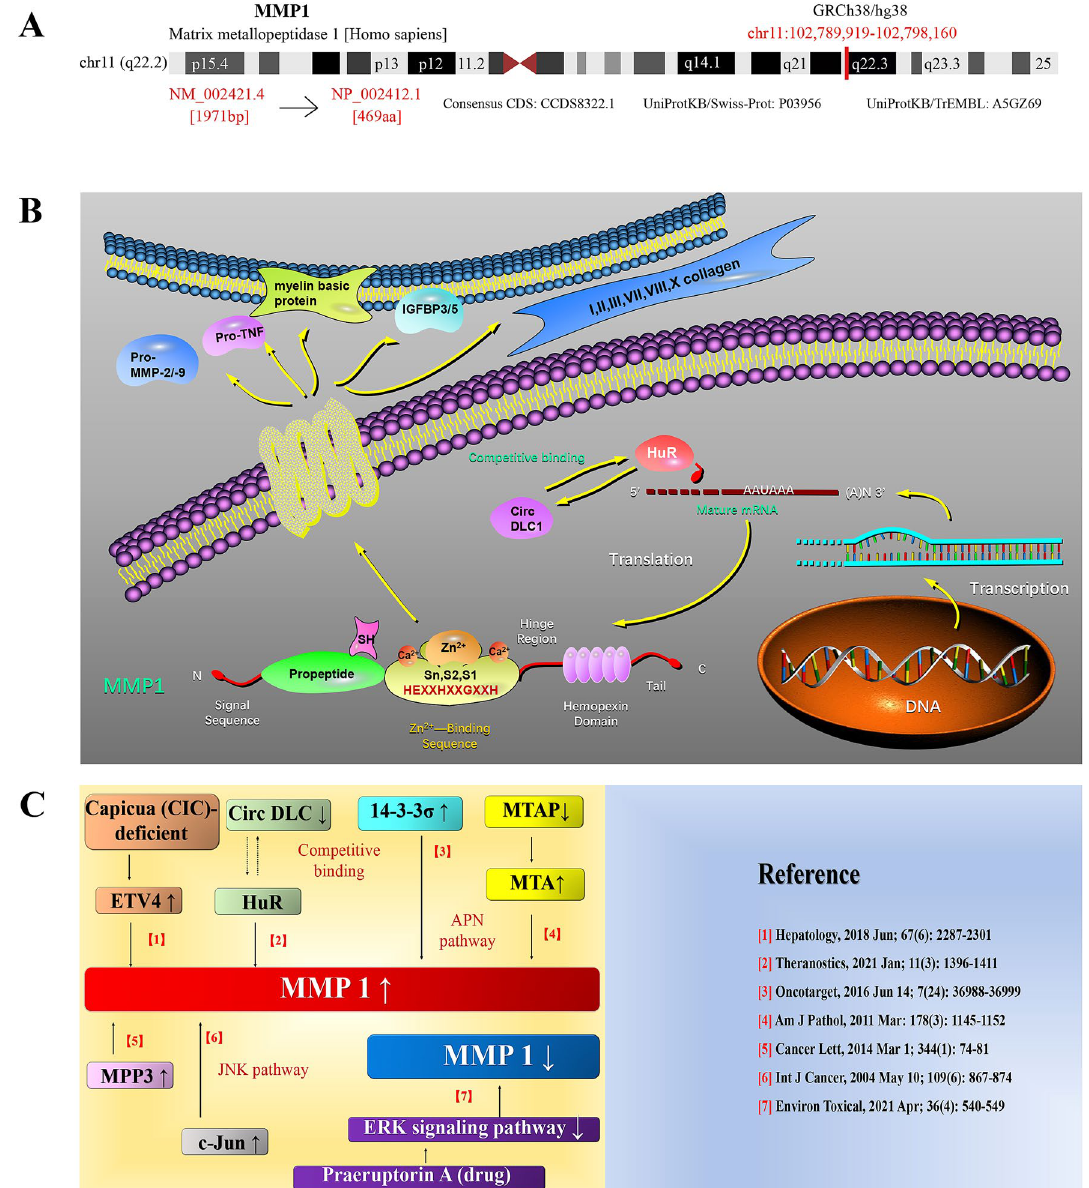
Figure 2. MMP1 gene information, mechanisms and pathways. ( A ) Genomic location and structural characteristics of human MMP1; ( B ) Potential mechanisms and pathways of MMP1; ( C ) The reported pathogenic pathways mediated by MMP1 in multiple cancers with relevant references